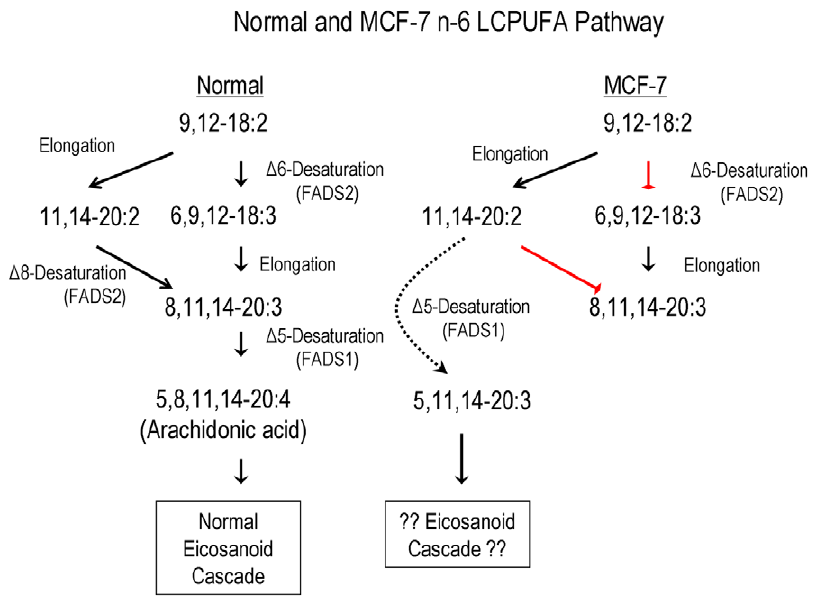
Figure 3. n 2 6 LCPUFA pathway in MCF7 cells. D 6- and D 8-desaturation steps are absent in MCF7, leading to D 5-desaturation of 11,14–20:2 to 5,11,14–20:3 when FADS1 is functional. The analogous pathways for n–3 LCPUFA convert 11,14,17–20:3 R 5,11,14,17–20:4 (not shown). FADS2 is also believed to be involved in C22 LCPUFA biosynthesis (not shown).